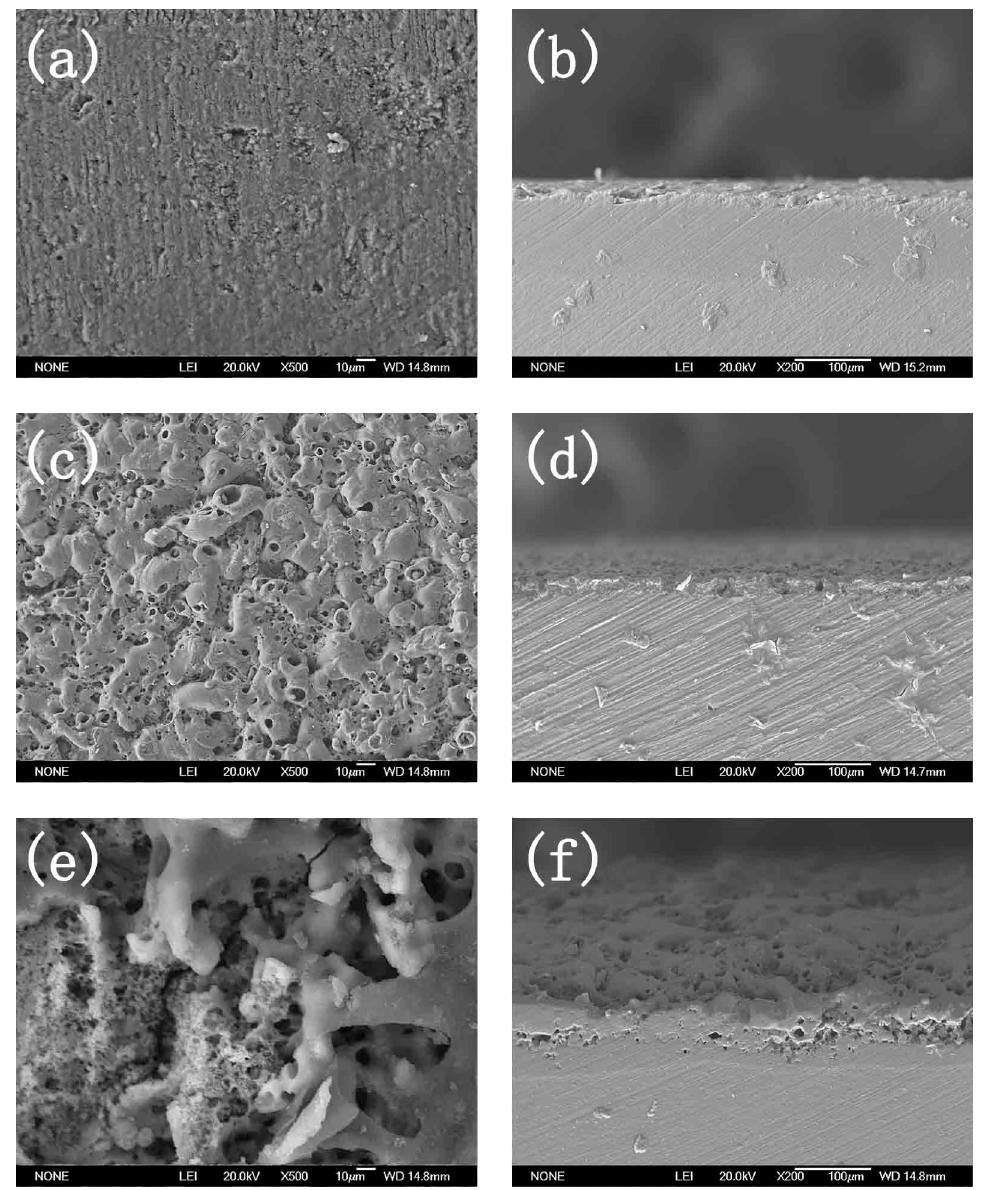
Figure 5. Micro-morphology ( a , c , e ) and cross section ( b , d , f) of anodic ( a , b ) and MAO coating with thickness of 25 microns ( c , d ) and 50 micons ( e , f ).